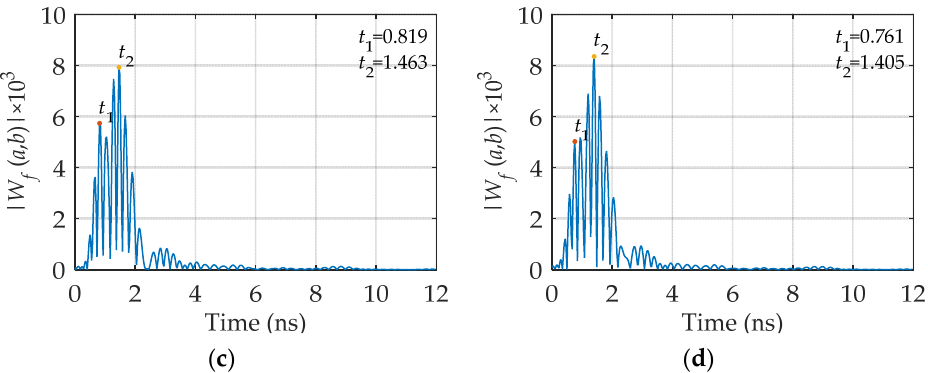
Figure 15. Modules curves of wavelet transform coefficients obtained by using different wavelet bases for typical single-channel signal on the survey line y 2 ( a = 10): ( a ) db2 wavelet basis; ( b ) db4 wavelet basis; ( c ) db6 wavelet basis; ( d ) db8 wavelet basis.